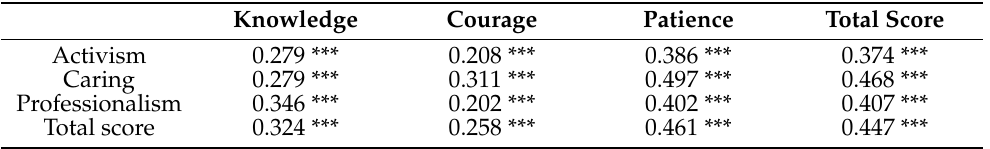
Table 3. Correlations between the CAI and NPVS-3